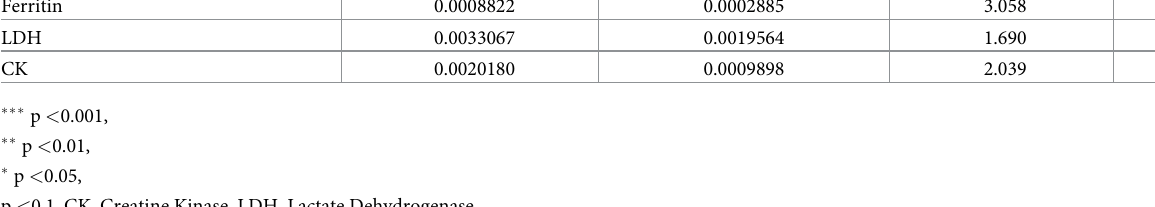
Cardiovascular disease